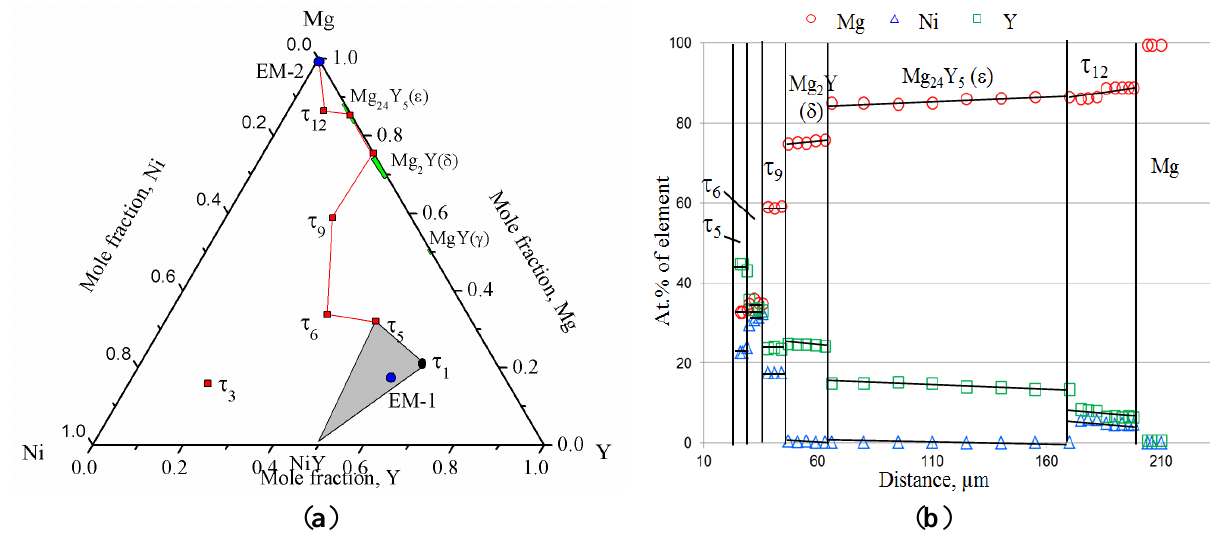
Figure 4. ( a ) Diffusion path projected on the Mg-Ni-Y Gibbs triangle; ( b ) Composition profile of the diffusion couple 1 along the line scan shown in Figure